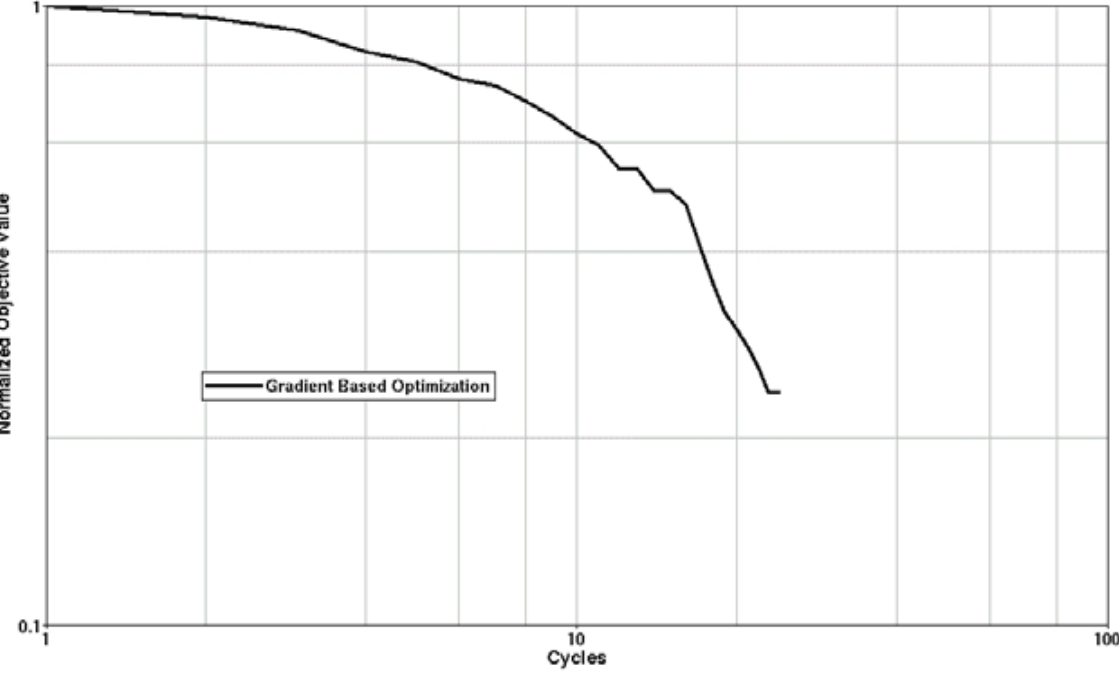
Fig. 3. Gradient based optimization performed by MSC/NASTRAN. Normalized objective function values are plotted against number of optimization cycles. Hard convergence was obtained in 25